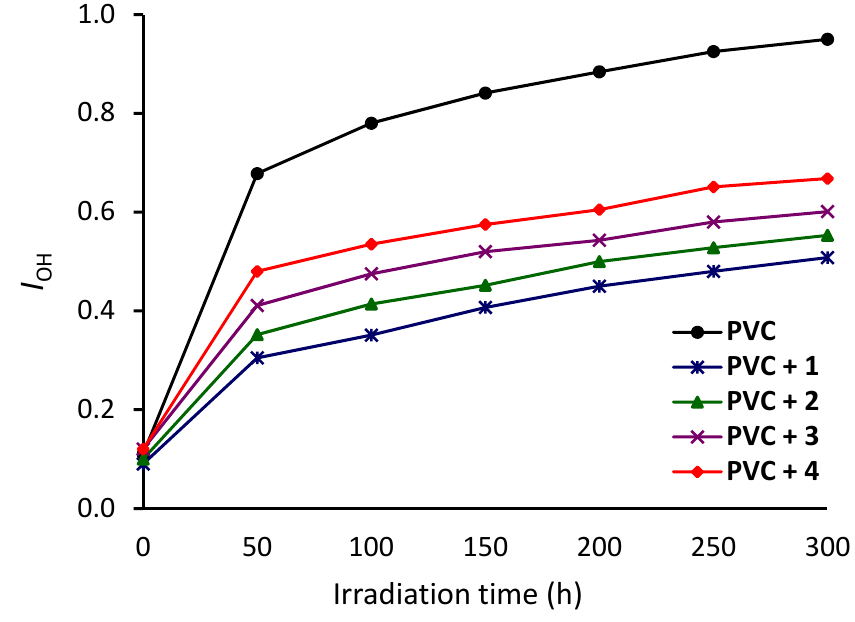
Figure 2. The I OH of the PVC films versus time.